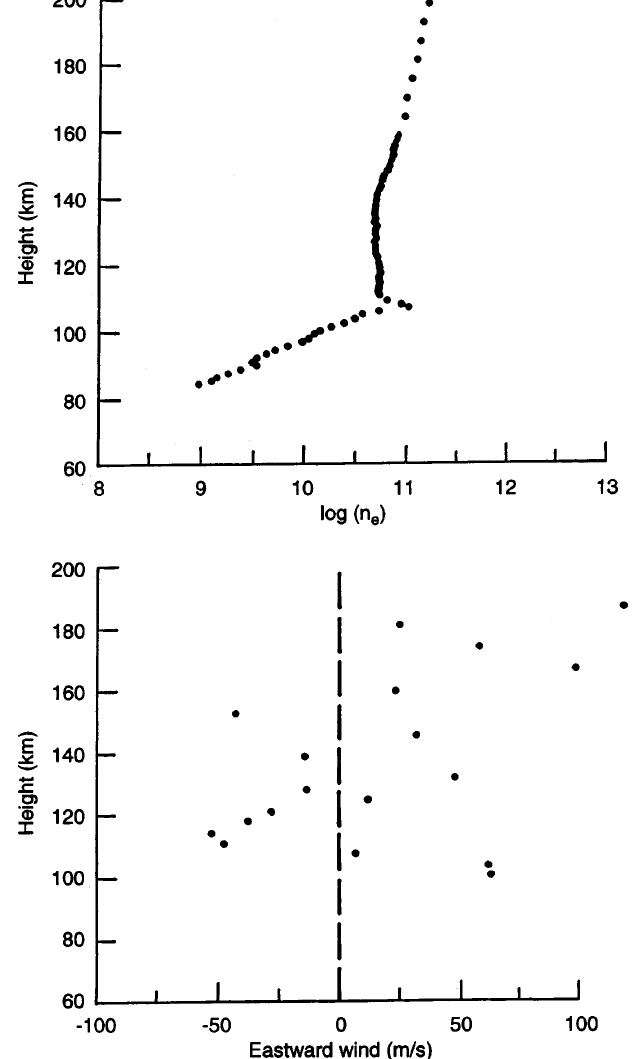
Fig. 1. Arecibo incoherent scatter radar data on April 19, 1977 at 2130 UT. The top panel shows the electron density as a function of height in a logarithmic plot. A sporadic E layer may be seen near 108 km. The bottom panel shows eastward neutral winds and a reversal from eastward to westward occurs near